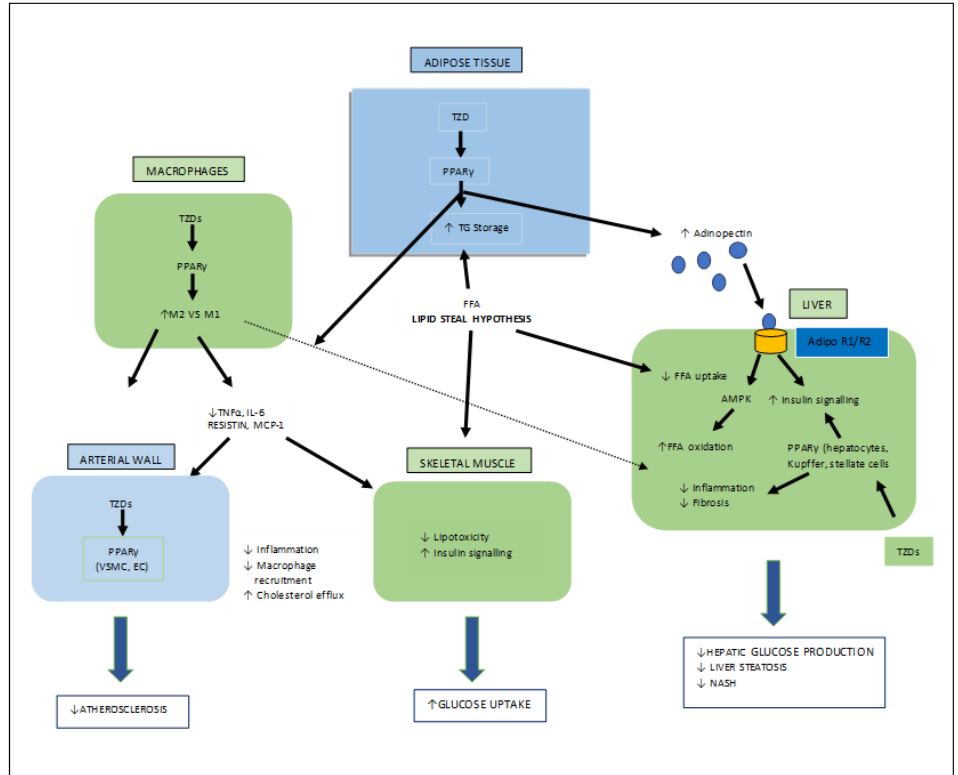
Figure 6. Various target organs/sites of TZD- PPARγ.